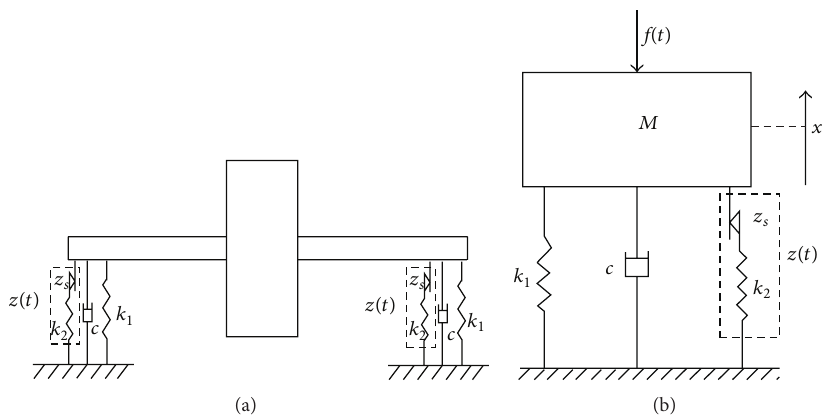
Figure 2: The one degree of freedom model of the rotor system with dry friction damper.